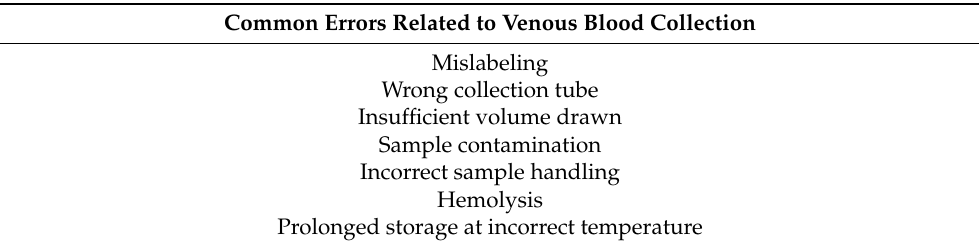
Table 1. Pre-analytical variables that could lead to poor blood sample